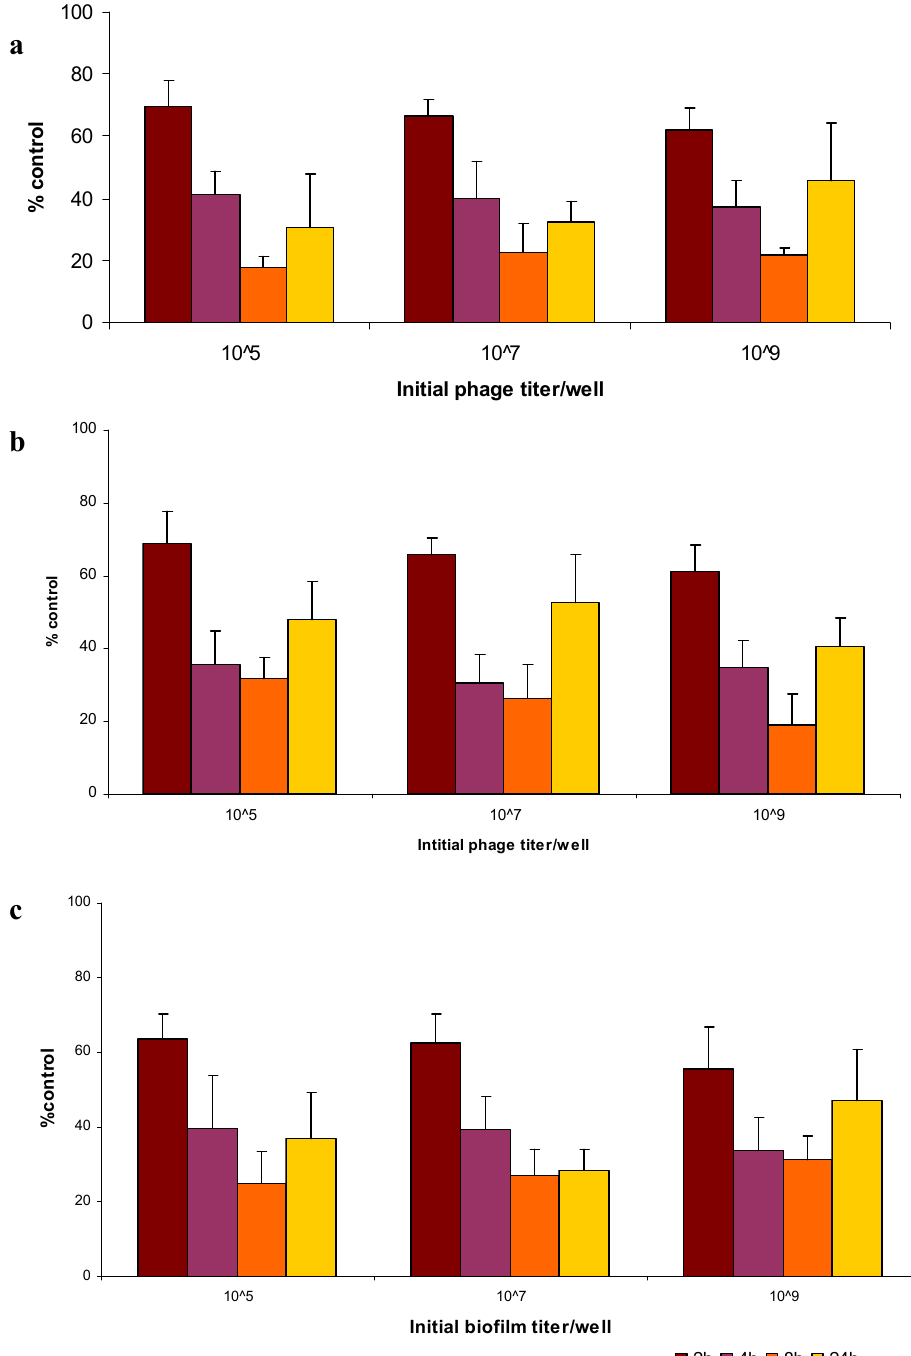
Figure 3. Phage disruption of established E. coli strain Can 91 biofilm. Biofilms grown in polystyrene microtiter plate wells for 48 h, were initially inoculated with 10 5 , 10 7 and 10 9 pfu of phages ( a ) ACG-C40 and ( b ) ACG-C91 ( c ) ACG-M12. After 2, 4, 8 and 24 h of phage treatment at 37 °C, average biofilm biomass in corresponding microtiter plate wells, were scored relatively to untreated control samples (100%) and represented on the Y-axes. Three independent experiments were performed, each starting from a different overnight culture and each with six repeats for each parameter combination. Error bars indicate standard error of